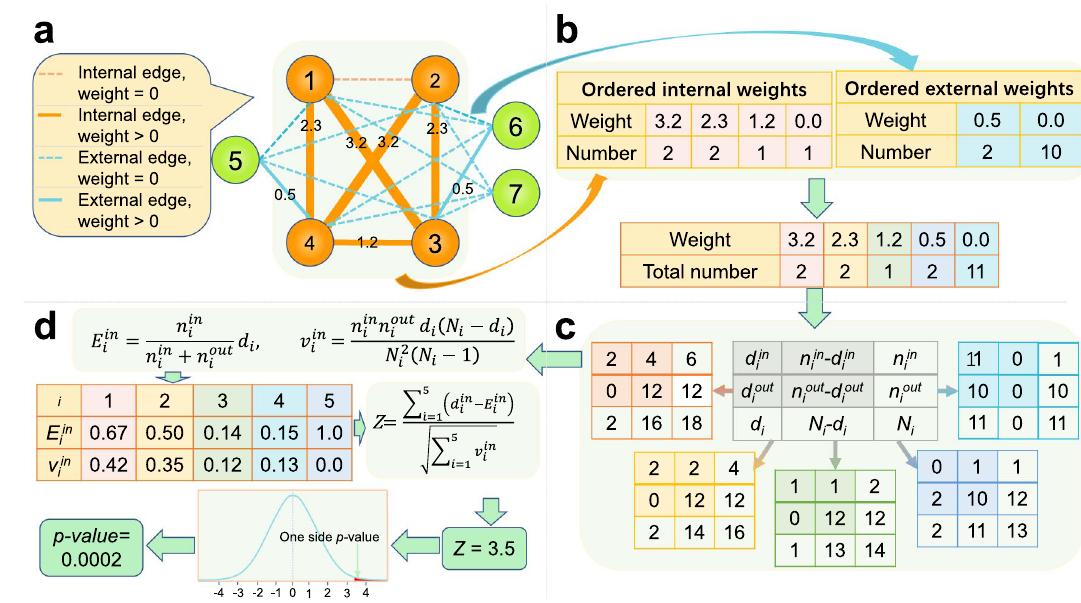
Figure 1. The main workflow of our method. ( a ) The network with augmented edge-weights for missing links. Each solid line represents a real edge and each dashed line denotes an augmented edge that is not included in E . In this network, there are totally 7 nodes and the candidate community is the sub-graph induced by the node set {1,2,3,4}. The size of each line is proportional to the corresponding edge-weight and the weights of augmented edges for missing links are zeros. ( b ) The ordered edge-weights. For the given candidate community in ( a ), we can construct two sets of edge-weights. One set is composed of the internal edge-weights and another set is composed of the external edge-weights. We can order these two sets to check if their empirical cumulative distribution functions are different. If the candidate community is not a real one, it can be expected that these two sets of weights have the same distribution. In Logrank test, these two sets are merged to generate a combined ordered edge-weight list. ( c ) Contingency tables for distinct weights. For each of the five distinct weights in ( b ), we can construct a contingency table. For instance, there are 2 edges whose weights are 3.2 and these two edges are internal edges, the first column of the leftmost table is (2, 0, 2). The second column of the